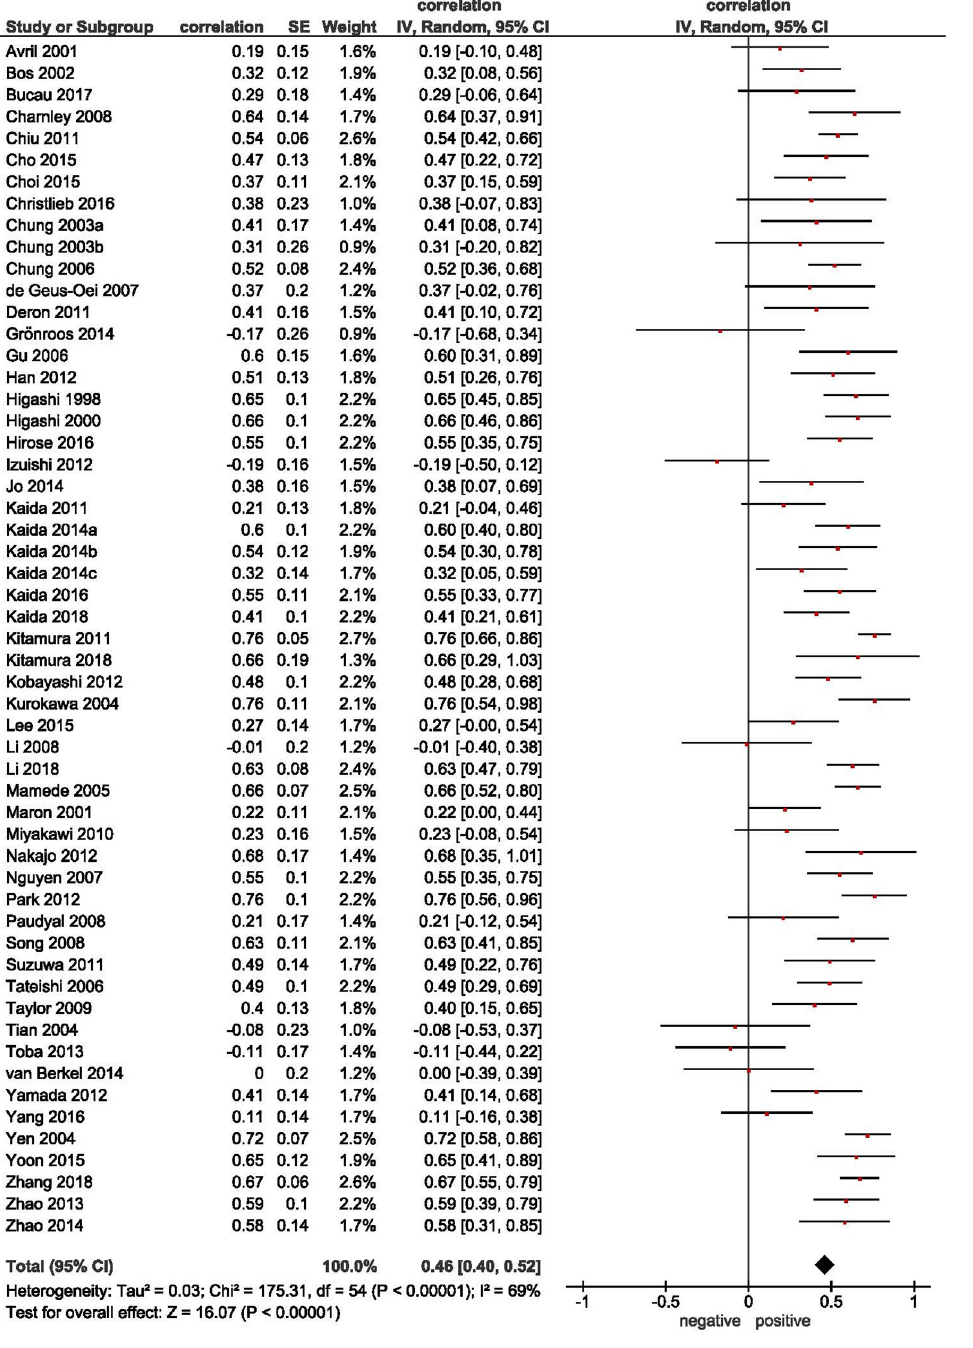
Fig 3. Correlation between SUVmax and GLUT 1 expression. Forrest plots of the correlations coefficients between SUVmax and GLUT 1 in all involved studies (n = 53) comprising 2291 patients. The pooled correlation coefficient was r = 0.46 (95% CI